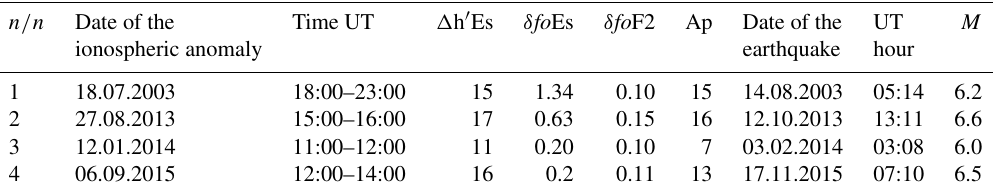
Table 6. Revealed ionospheric anomalies during disturbed magnetic conditions (AE larger than the imposed limits) and corresponding earthquakes, daily Ap indices are given as